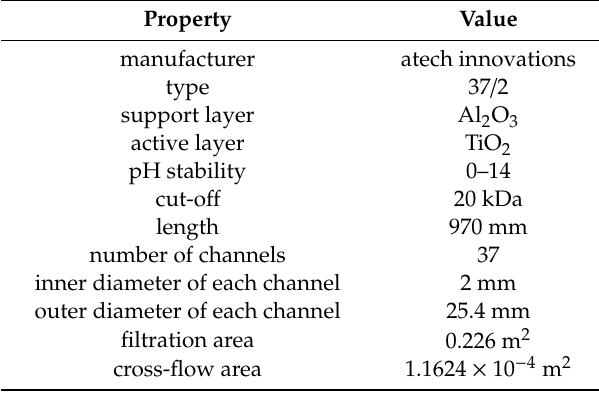
Table 3. Properties of the ceramic membrane used in this